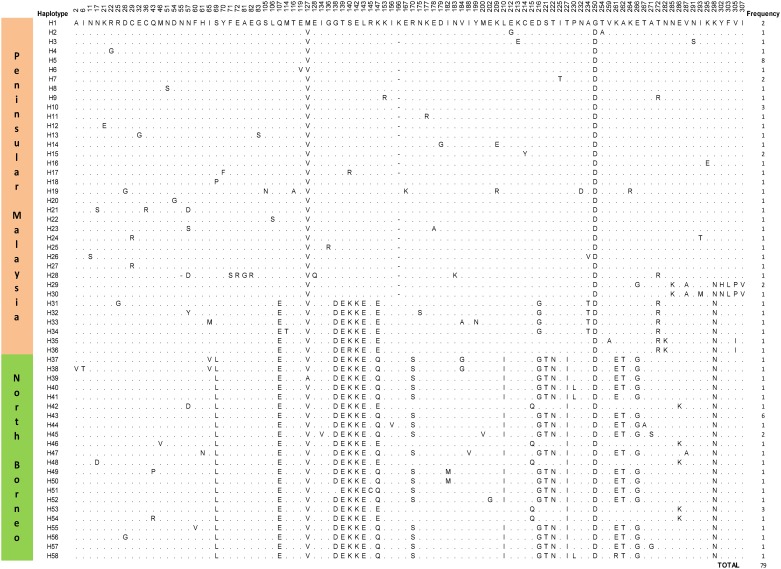
Amino acid sequence polymorphism in the PkγRII haplotypes from Peninsular Malaysia and North Borneo.Polymorphic amino acid residues are listed for each haplotype. Residues identical to those of haplotype H1 are marked by dots. Total number of sequences for each haplotype is listed in the panel on the right.